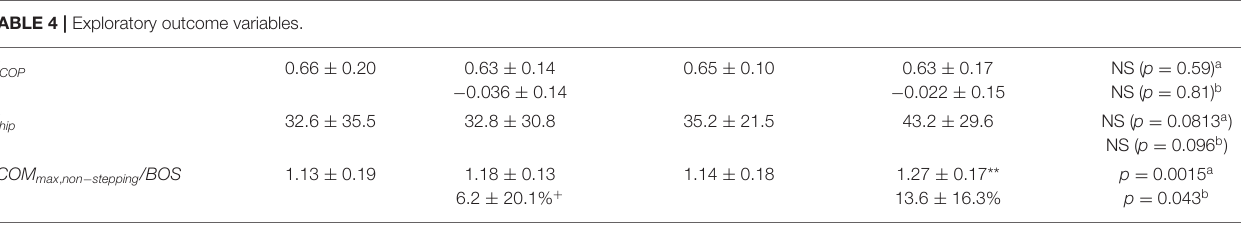
TABLE 4 | Exploratory outcome variables.